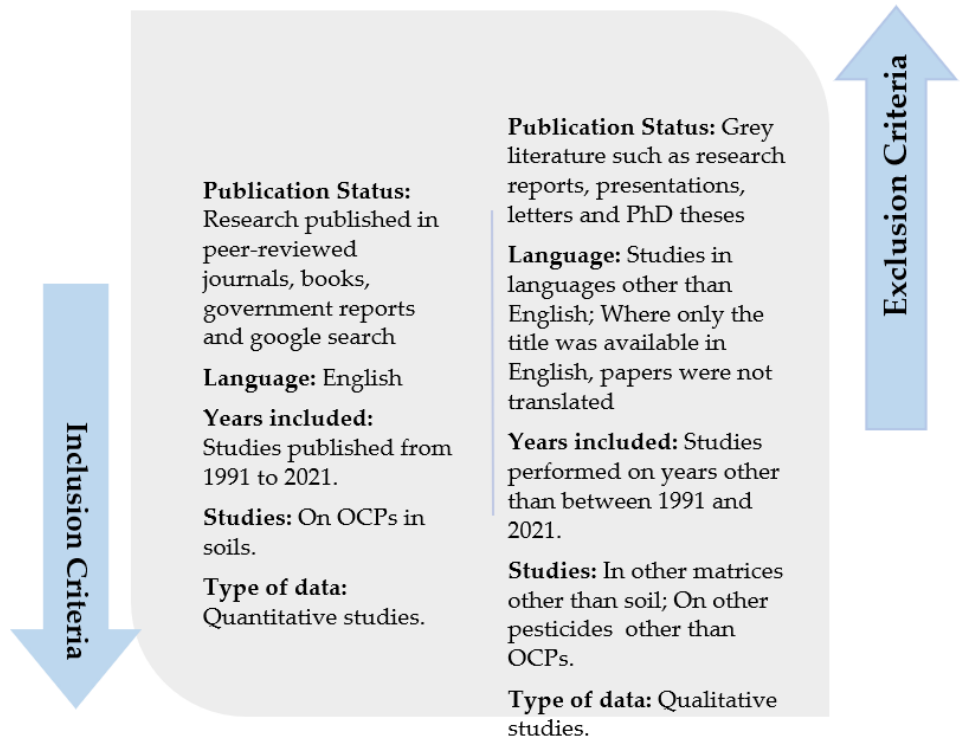
Figure 1. Overview of inclusion and exclusion criteria for the systematic review.